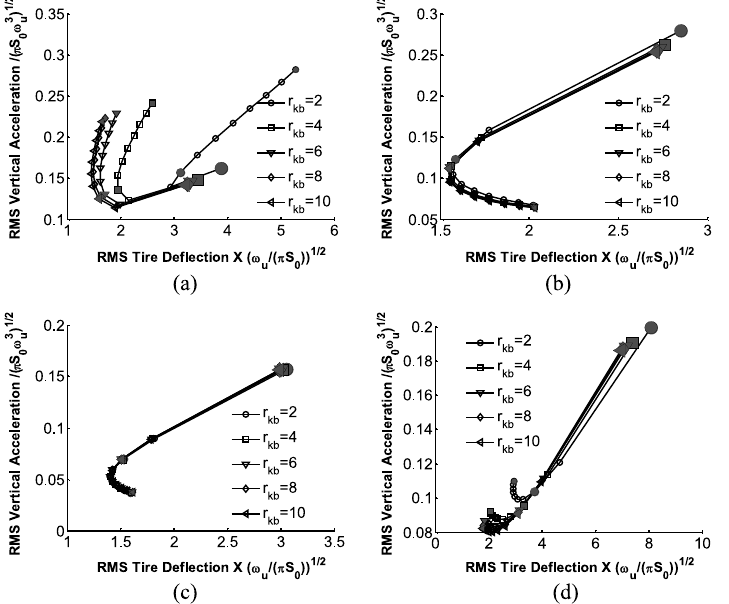
Fig. 13. Relationship between RMS acceleration and RMS tire de fl ection with layout s8 (effect of centering spring k b and damping): (a) Passive; (b) Groundhook; (c) Hybrid; (d)